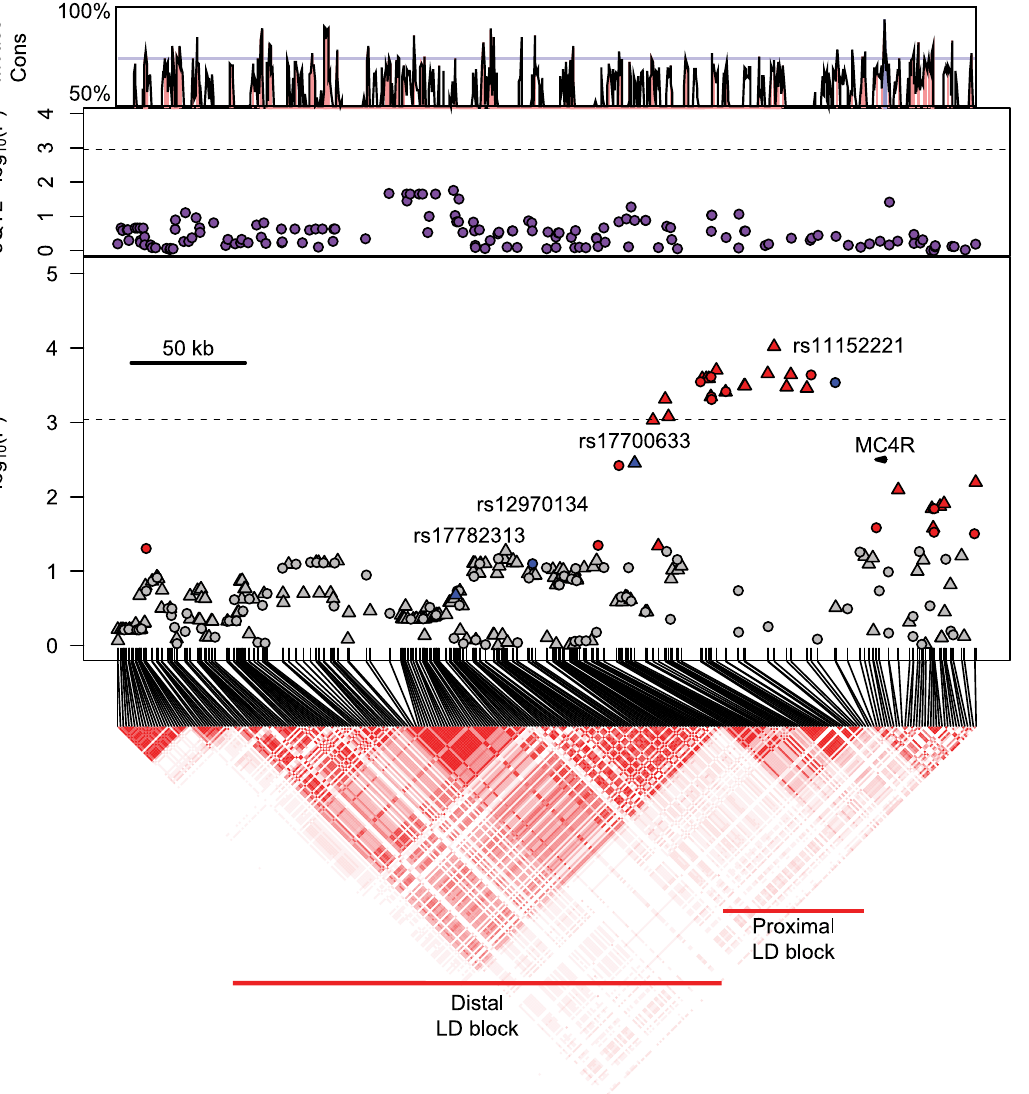
Figure 2. Association between BMI and genotyped and imputed SNPs in white Health ABC participants. SNP genotypes from genome- wide Illumina array. In the panel displaying BMI association P -values, circles mark directly genotyped SNPs and triangles mark imputed SNPs. Gray points indicate association P -value . 0.05. Red points indicate significant ( P -value # 0.05) associations with BMI. Anchor SNPs colored in blue. Purple circles mark SNP association with MC4R expression in HapMap CEU lymphoblastoid cell lines. In the panels showing trait association and eQTL P - values, the dashed line indicates cut-off value for Bonferroni-corrected P -value # 0.05. LD heatmap indicates higher r 2 measures with darker red colors. Nucleotide conservation between the human and mouse is indicated on the top panel of the figure and was obtained using the VISTA browser.